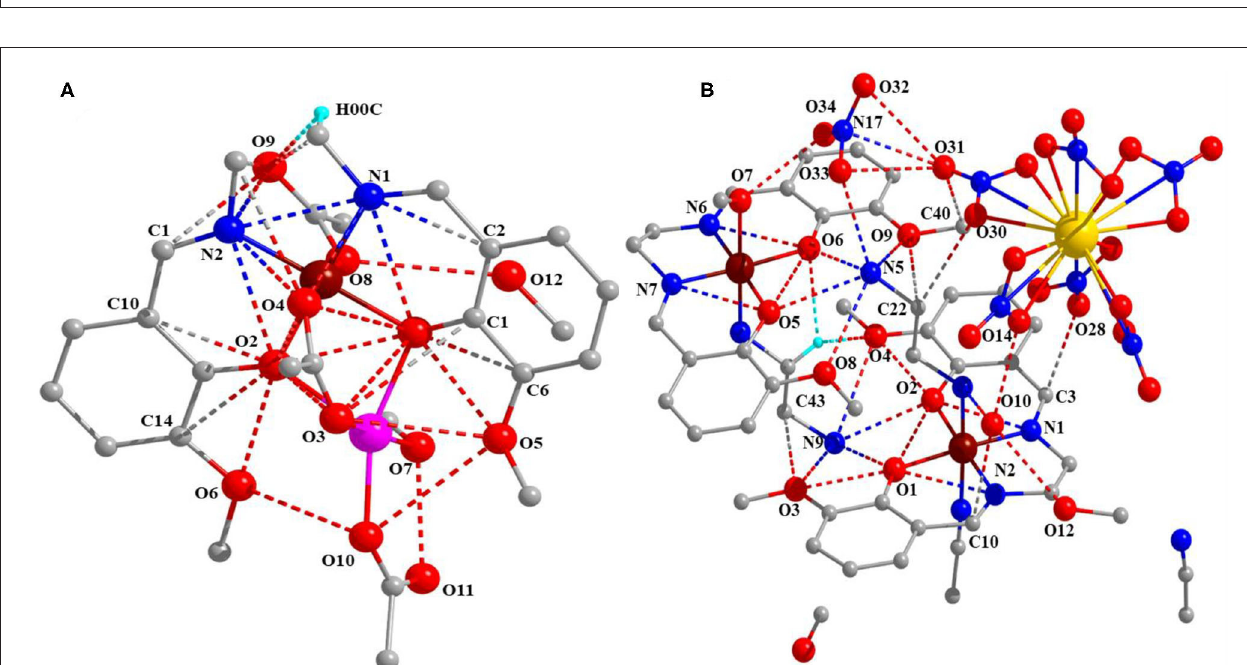
FIGURE 3 | Van der Waals interaction (A) complex 1 and (B) complex